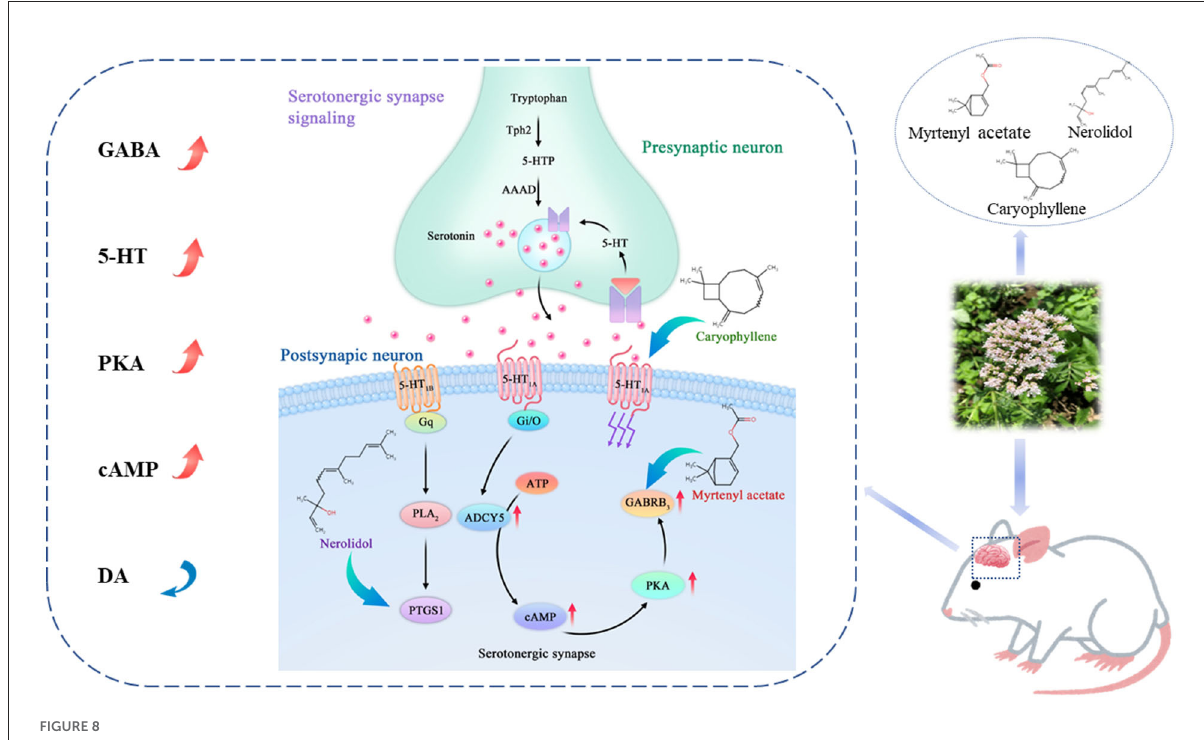
FIGURE8 Mechanism